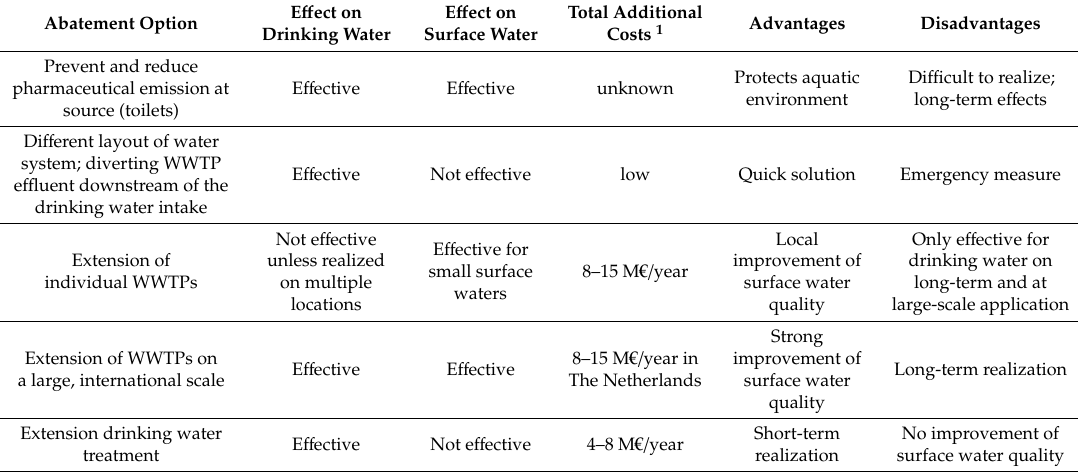
Figure 4. Contribution of several sources to the pharmaceutical and metabolite concentration at the intake of drinking water production site Heel. The dark shaded bars are based on load predictions from the actual measurements of concentrations and discharges in November and December 2011. The lighter shaded bars are generalized load predictions for low (comparable to November), median (comparable to December) and extremely high discharge. Table 2. Potential abatement options to improve quality of surface waters and the source water for drinking water treatment at the production site